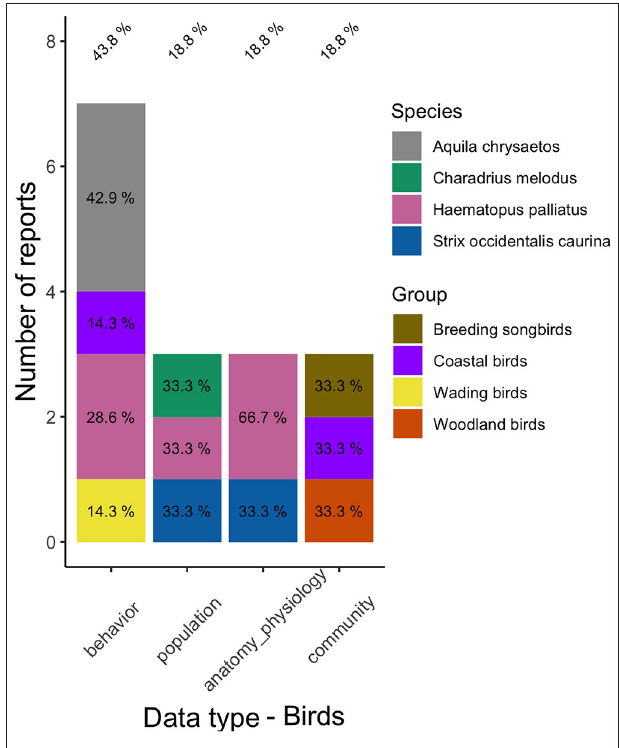
FIGURE 8 | Number of reports that accessed the impacts of off-road vehicle (ORV) use on birds ( n = 16) across the type of data collected (behavior, population, anatomy/physiology, and community) Results are categorized by species or group of birds that were